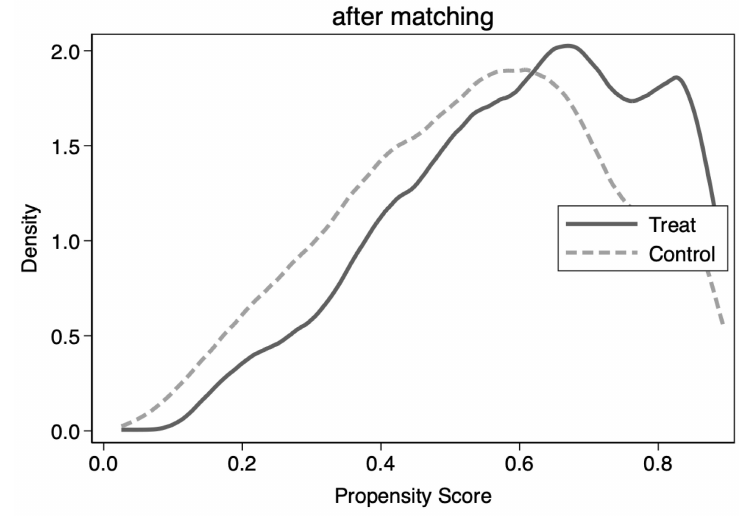
Figure 4. Kernel density of treated and control groups after matching.